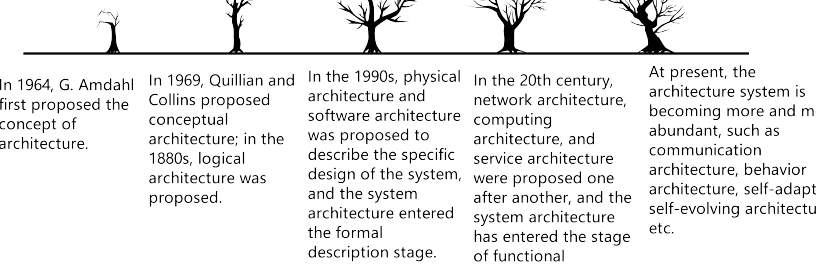
Figure 3. The development process of system